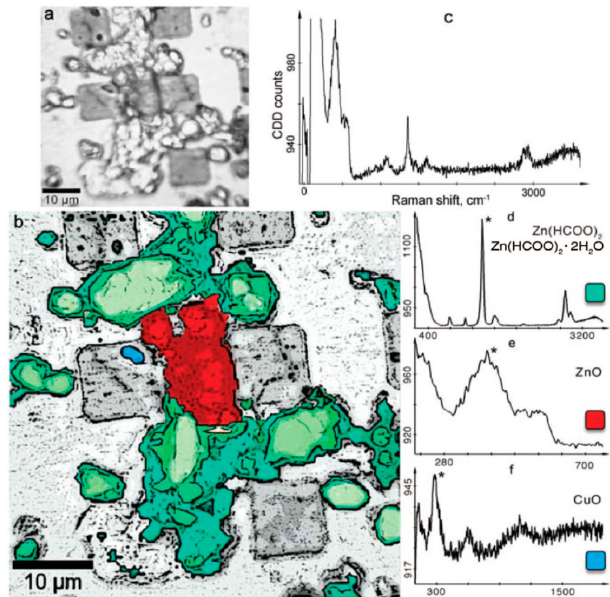
Figure 18. Confocal Raman image analysis of a patterned sample exposed for 5 days in 100 ppb formic acid in 80% RH. ( a ) An optical microscope image of the analyzed area; ( b ) A summary image of the local distribution of species based on interpolation of their characteristic Raman signals. The green color corresponds to interpolation between 1325 and 1435 cm − 1 ( d *) and denotes Zn(HCOO) 2 and Zn(HCOO) 2 ·2H 2 O. The red color corresponds to interpolation between 320 and 490 cm − 1 ( e *) and denotes poorly crystalline ZnO. The blue color corresponds to the interpolation between 250 and 320 cm − 1 ( f *) and denotes CuO; ( c ) An average spectrum of the red area. On the right-hand side there are average spectra ( d – f ) for the presented species in ( b ). Reproduced from reference [107] by permission of The Electrochemical Society. Copyright 2013.